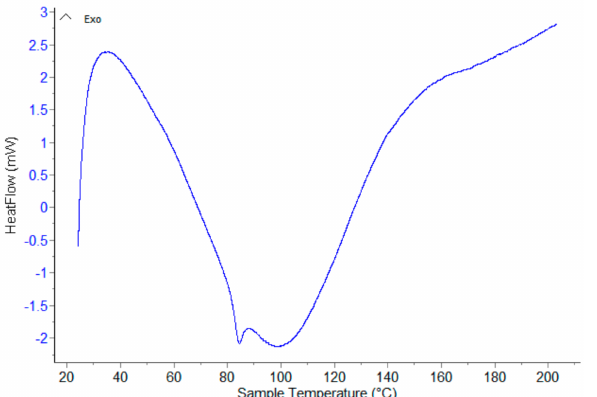
Figure A7. The DSC thermogram of RUT-HP- β -CD complex, dynamic nitrogen atmosphere, β = 10 K min − 1